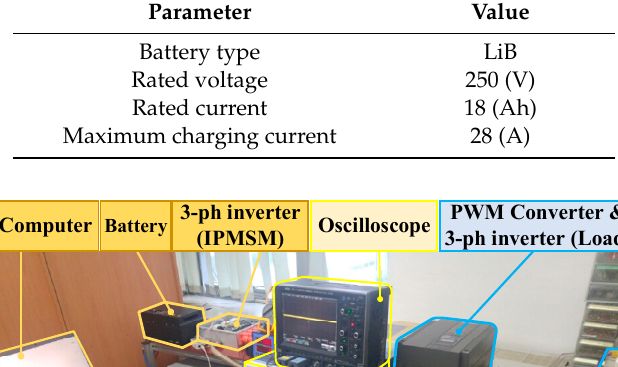
Table 2. Battery parameters.